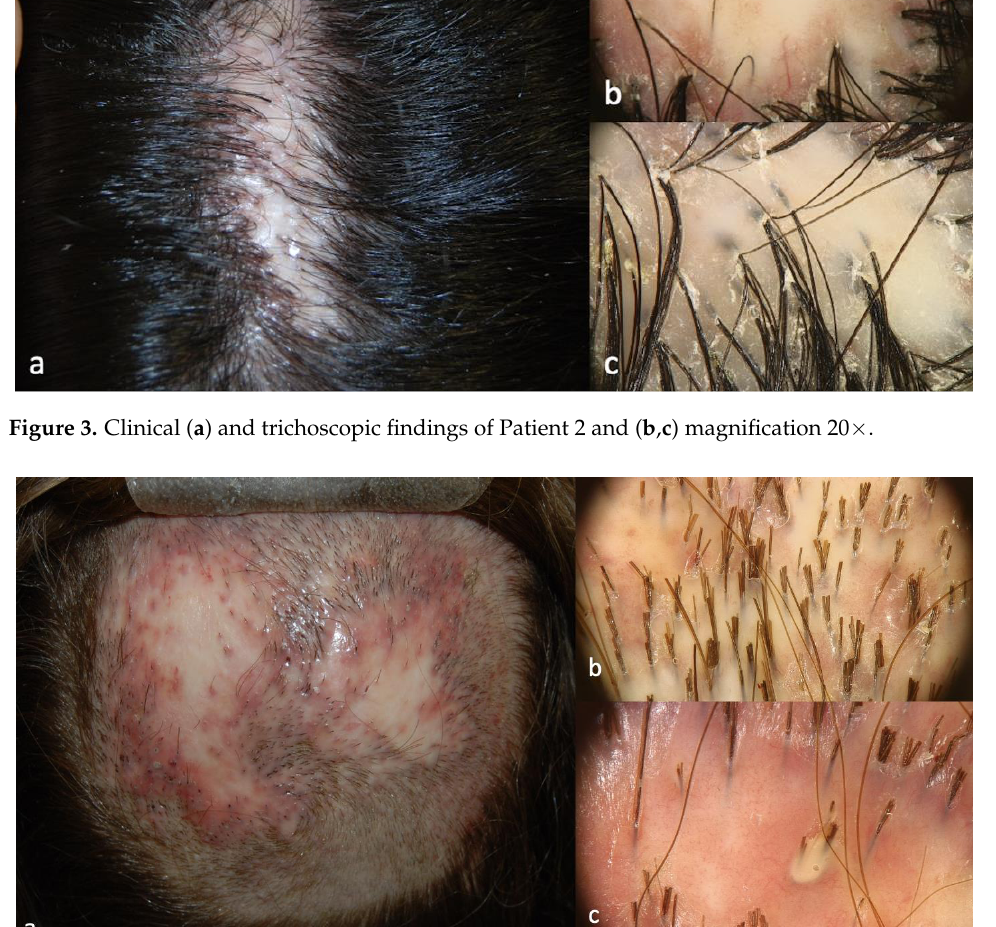
Figure 4. Clinical ( a ) and trichoscopic findings of Patient 3, ( b ) magnification 20×, and ( c ) magnifi- cation 40×.